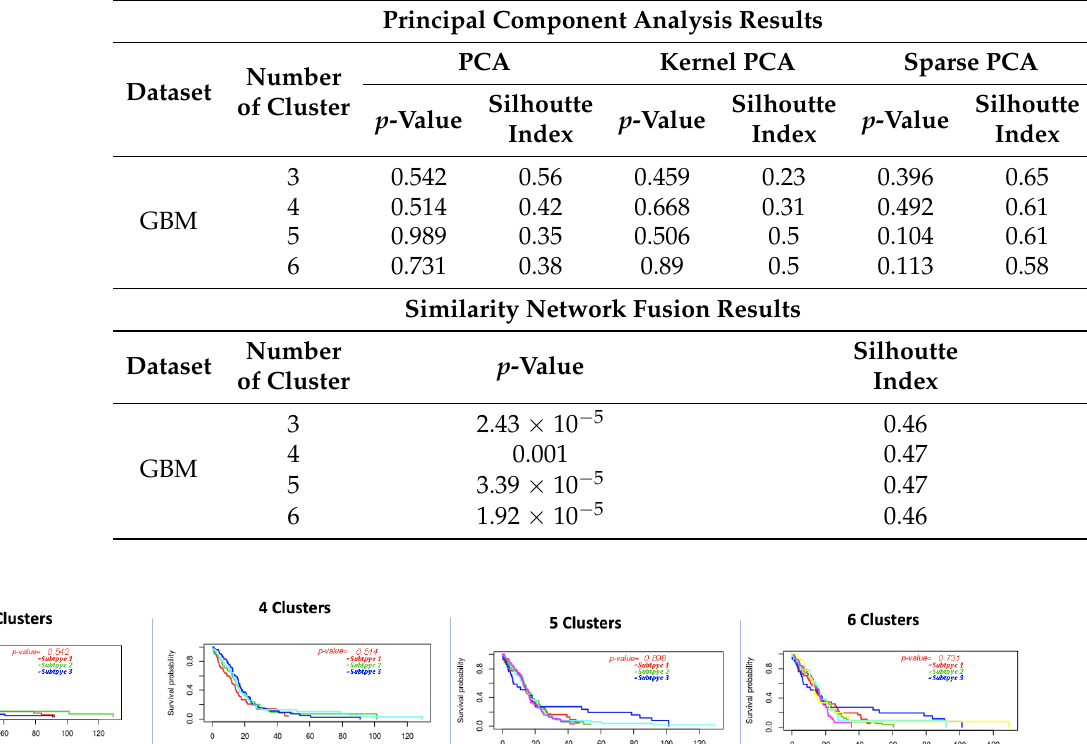
Table 4. PCA and SNF Results.